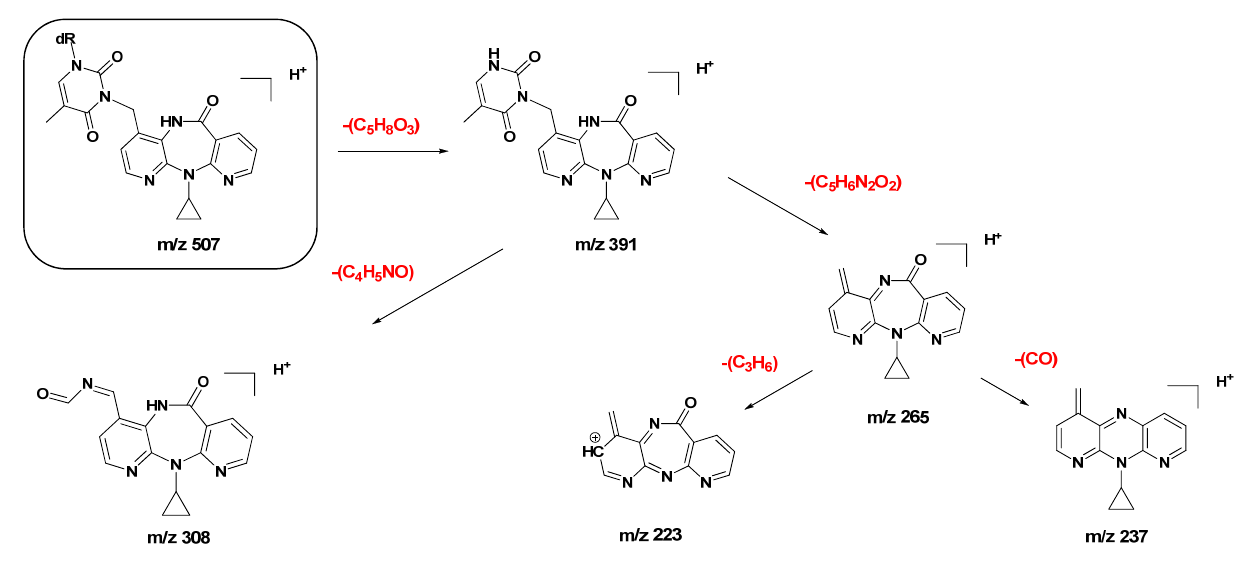
Scheme 1. Proposed ESI-MS/MS fragmentation mechanisms for the protonated molecule ( m/z 507) of N3-NVP-dT ( 9